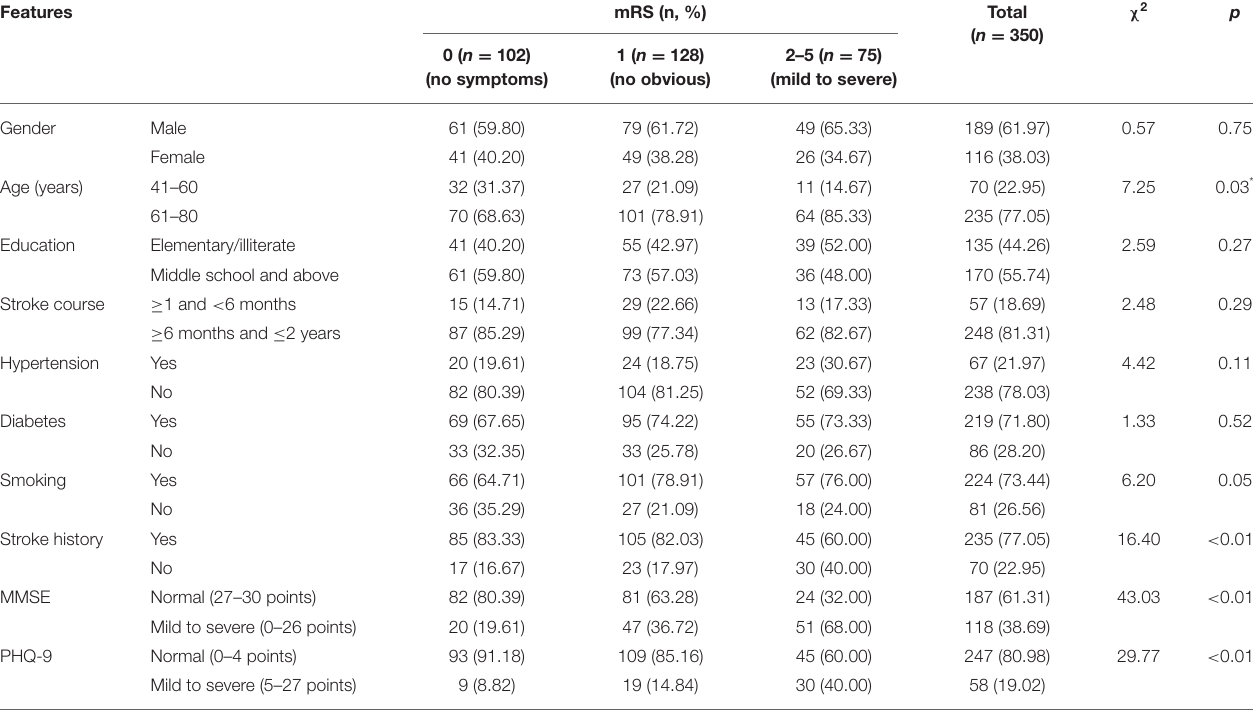
TABLE 4 | Comparison between basic data, vascular risk factors and health status among ischemic stroke patients ( n = 350). Features